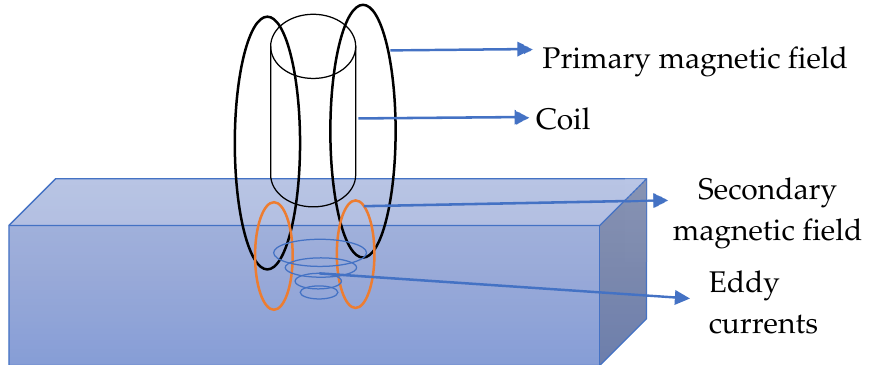
Figure 9. The schematic representation of the MEC principle.